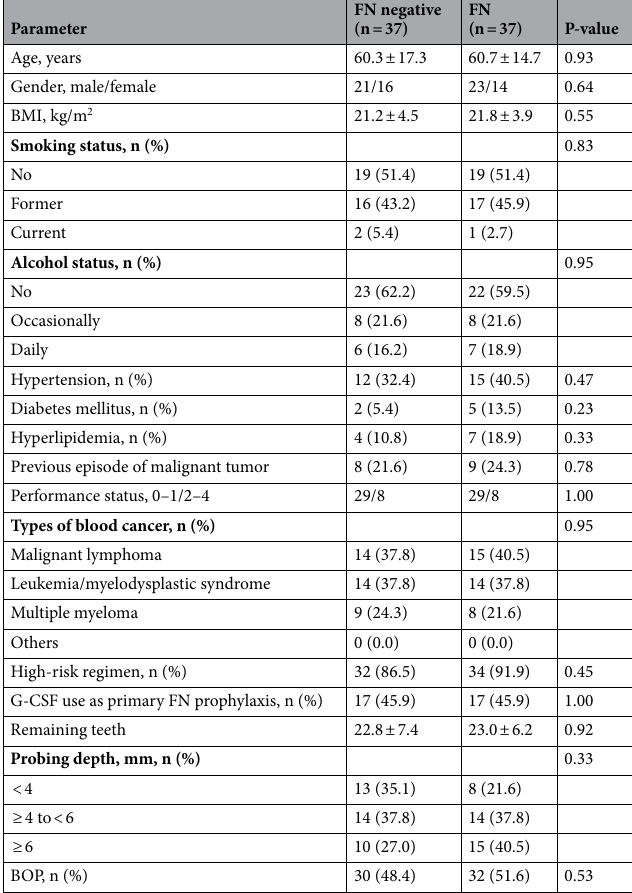
Table 4. Comparison of clinical characteristics between FN and the FN negative groups after propensity score-matching.